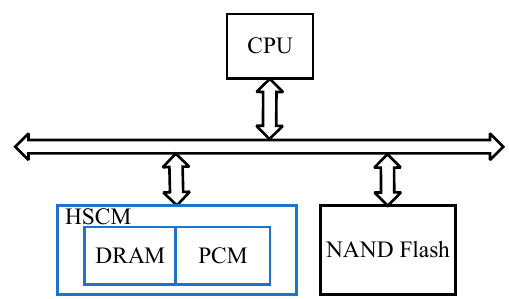
Figure 1. Hybrid storage class memory architecture.